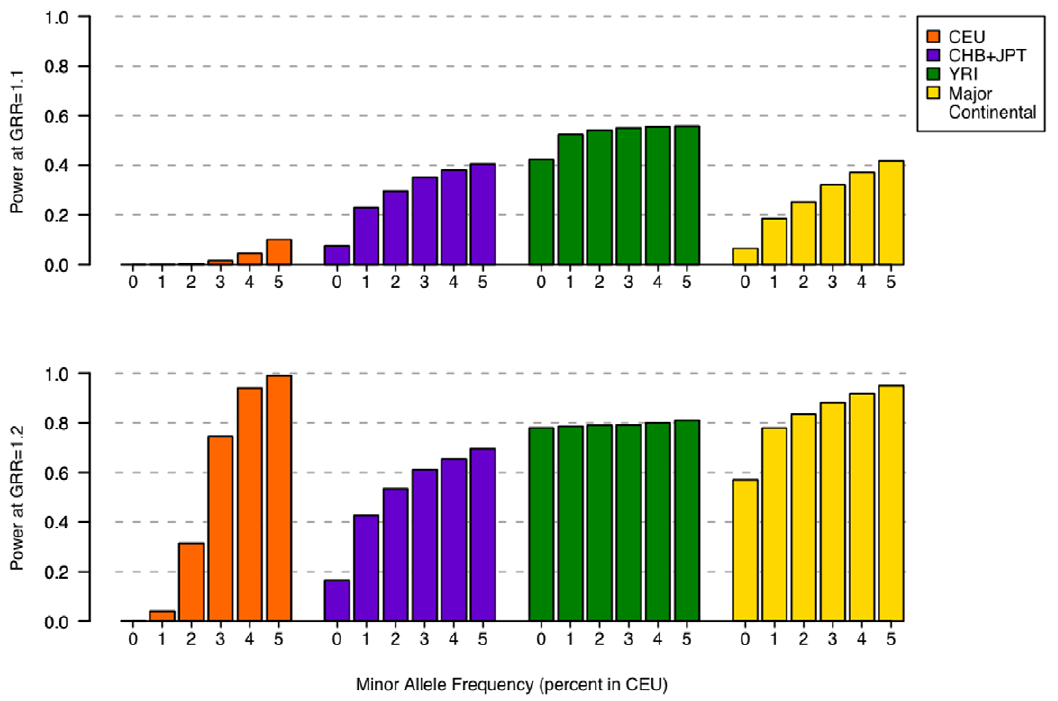
Figure 4. Power as a function of allele frequency ( # 5%) in CEU using 1000 Genomes Project data. For a sample size of 80,000 and modest effect size (GRR of 1.1 and 1.2), power is given for three individual panels (CEU, CHB + JPT, YRI) and a multiethnic panel in phase 2. Including non-European samples in phase 2 improves power to detect an association for alleles that have lower frequency in CEU.